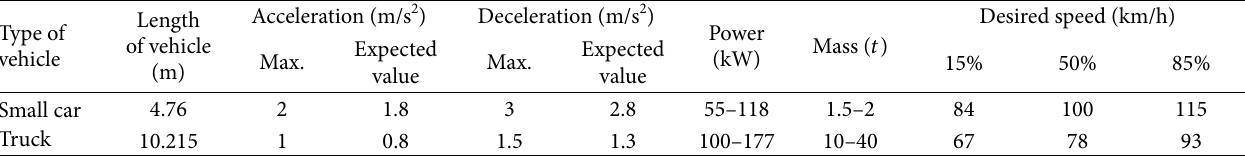
Table 2: Parameter setting of vehicles.